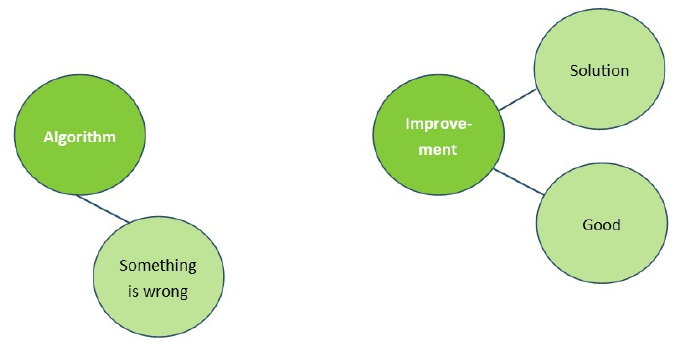
Figure 4. Associations and automatic activation before bug fix.